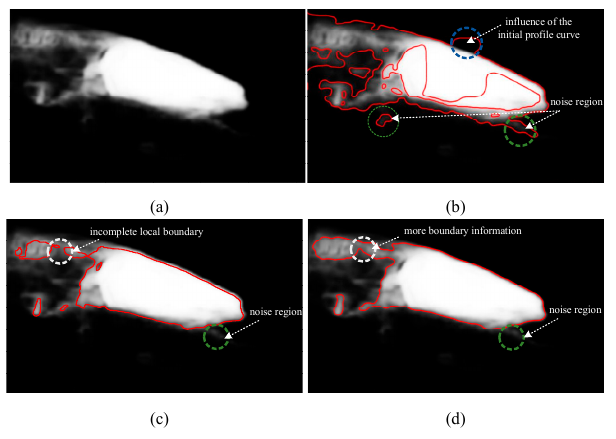
Figure 2. The contour extraction results. ( a ) Original saliency image. ( b ) The result of the local intensity fitting. ( c ) The result of the global intensity fitting. ( d ) The result of our method.